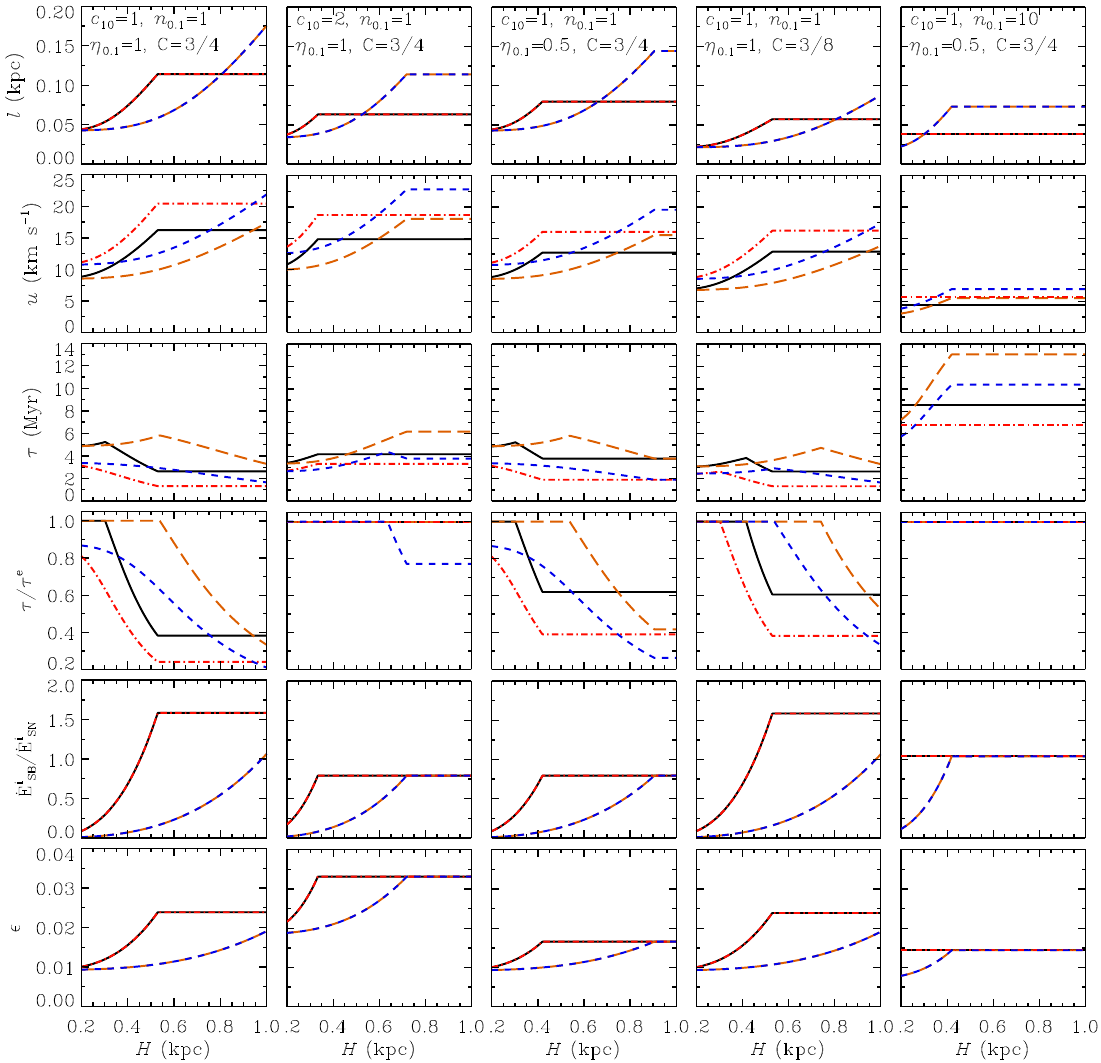
Figure 3. Turbulence parameters estimated for various choices of the model parameters in Table 1. The horizontal axis is the density scale height. From the top to bottom row, the vertical axis shows (i) the correlation scale l , (ii) the root-mean-square (RMS) turbulent velocity u , (iii) the correlation time scale τ = min ( τ e , τ r ) , (iv) the Strouhal number St = τ / τ e = τ u / l , (v) the ratio of energy density per unit time injected by SBs and isolated SNe ˙ E i / ˙ E i , and (vi) the efficiency of converting SB SN SN energy to turbulent energy (cid:101) = ˙ E i / ( ν E 0 ) . Each column corresponds to a different set of values for the parameters c 10 , n 0.1 , η 0.1 and C , with values indicated on the top row plots. In each panel, four cases are shown: ν 50 = 1 and N SB = 100 (solid black), ν 50 = 1 and N SB = 1000 (long-dashed orange), ν 50 = 2 and N SB = 100 (dashed-dotted red), and ν 50 = 2 and N SB = 1000 (short-dashed blue). The solid black curve in the leftmost column with H = 0.4kpc corresponds to our fiducial